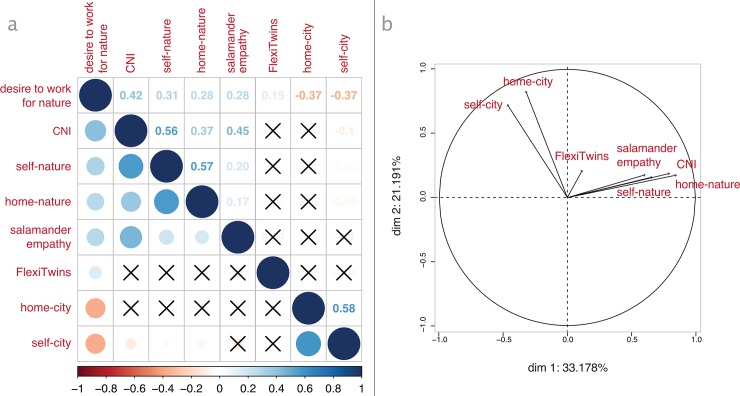
Correlation table and principal component analysis.(a) Spearman correlation table for all quantitative methods employed. Crossed elements are non-significant (p>.1). The strength of correlations is reported in the upper triangle. (b) Two-dimensional visualization of coordinates obtained from the principal component analysis for children’s desire to work for nature.